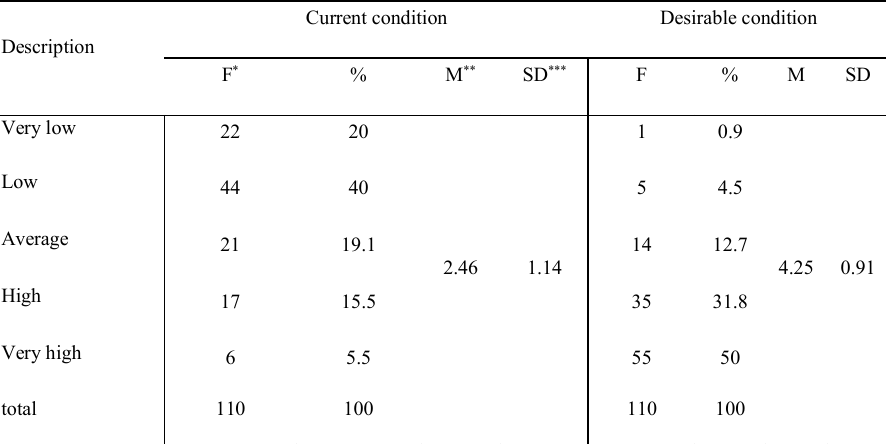
Table 6: Relative distribution of respondents in terms of their views on the role of the total index of social and cultural factors in conserving and restoring the historic textures of